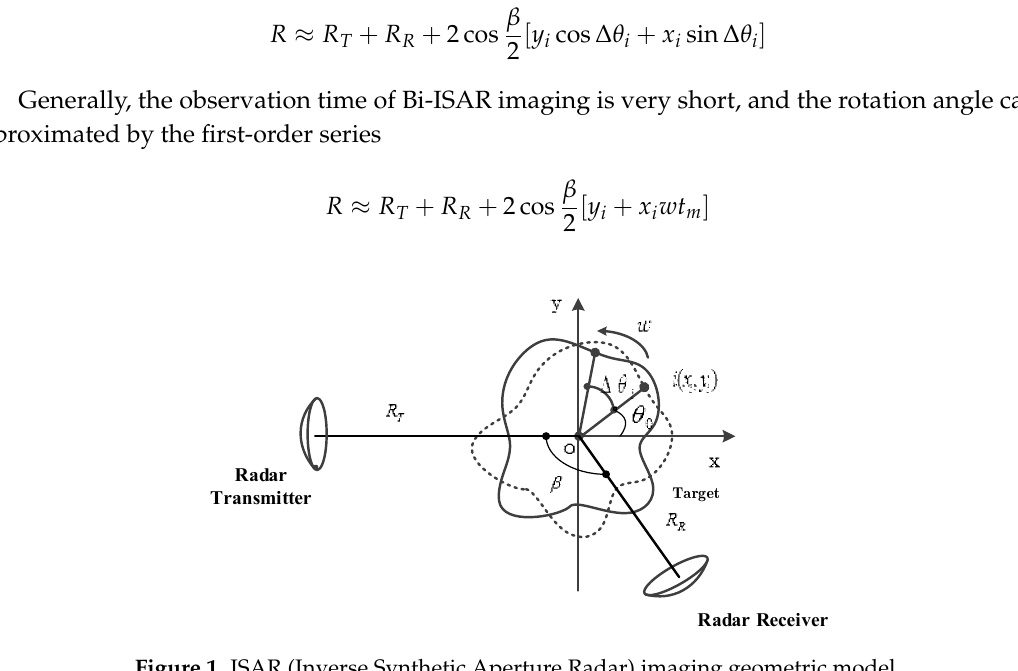
Figure 1. ISAR (Inverse Synthetic Aperture Radar) imaging geometric model.